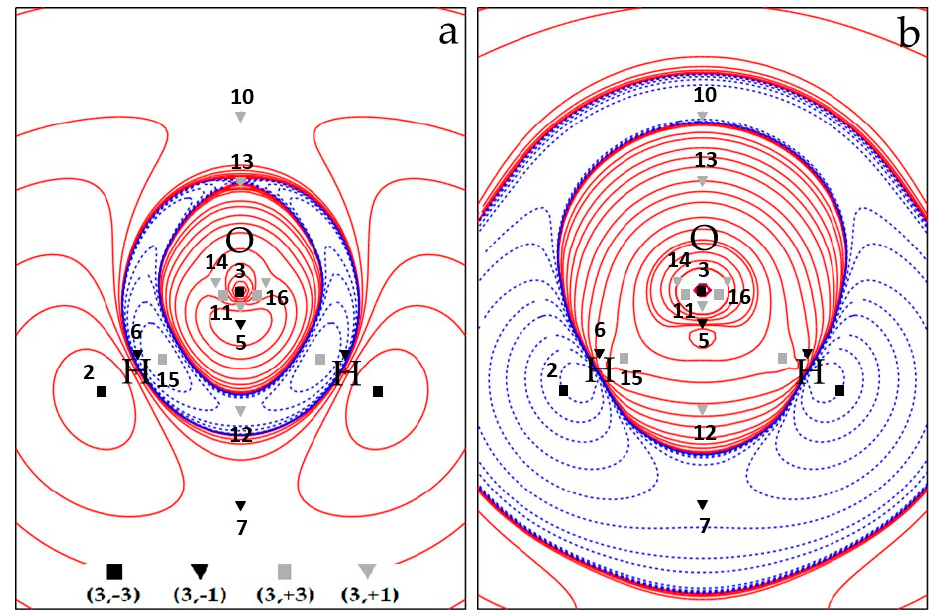
Figure 1. CAS contour plots in the σ v plane of 3 B 1 H 2 O containing the three nuclei: ( a ) electron spin density s and ( b ) electron spin density Laplacian ∇ 2 s. Contour maps are drawn in intervals of ± (2, 4, 8) × 10 − n , 0 ≤ n ≤ 6 au (e − (bohr) − 3 and e − (bohr) − 5 for electron spin density and electron spin density Laplacian, respectively). Spin density CPs are shown on both maps, the unique ones labelled also by their identification number N (Tables 2 and 3). CPs’ 6 locations are projected on this map (see text for more details). Solid red contour lines corresponds to s or ∇ 2 s positive values, while the dashed blue contour lines correspond to negative s or ∇ 2 s values. The solid squares mark (3, − 3) CPs, the solid triangles (3, − 1) CPs, gray triangles (3, +1) CPs and gray squares (3, +3) CPs. Note that, in this figure, in Figure 2 and in all figures of the Supplementary Materials, the atomic nuclei are located in the close neighbourhood of the atomic labels.